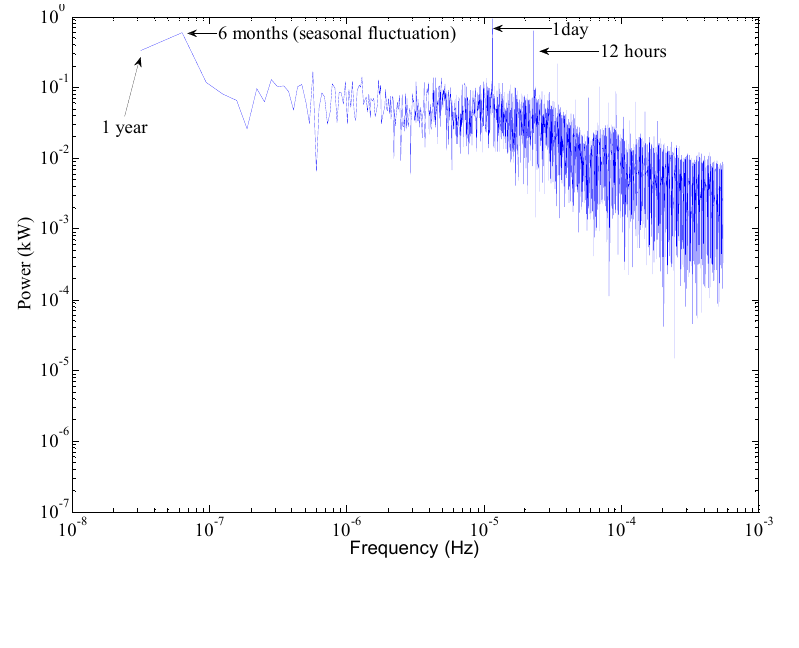
Figure 3. Spectrum analysis of the net power profile within the microgrid during a